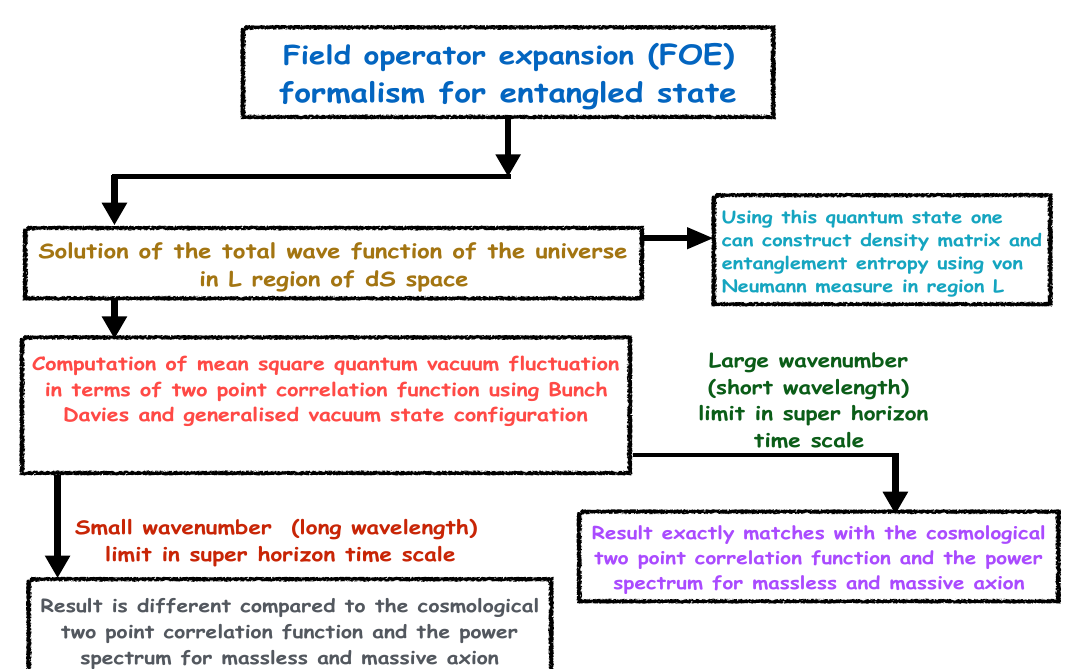
Figure 5. Schematic diagram for the computation algorithm of field operator expansion method for entangled state of axion in de Sitter hyperbolic open